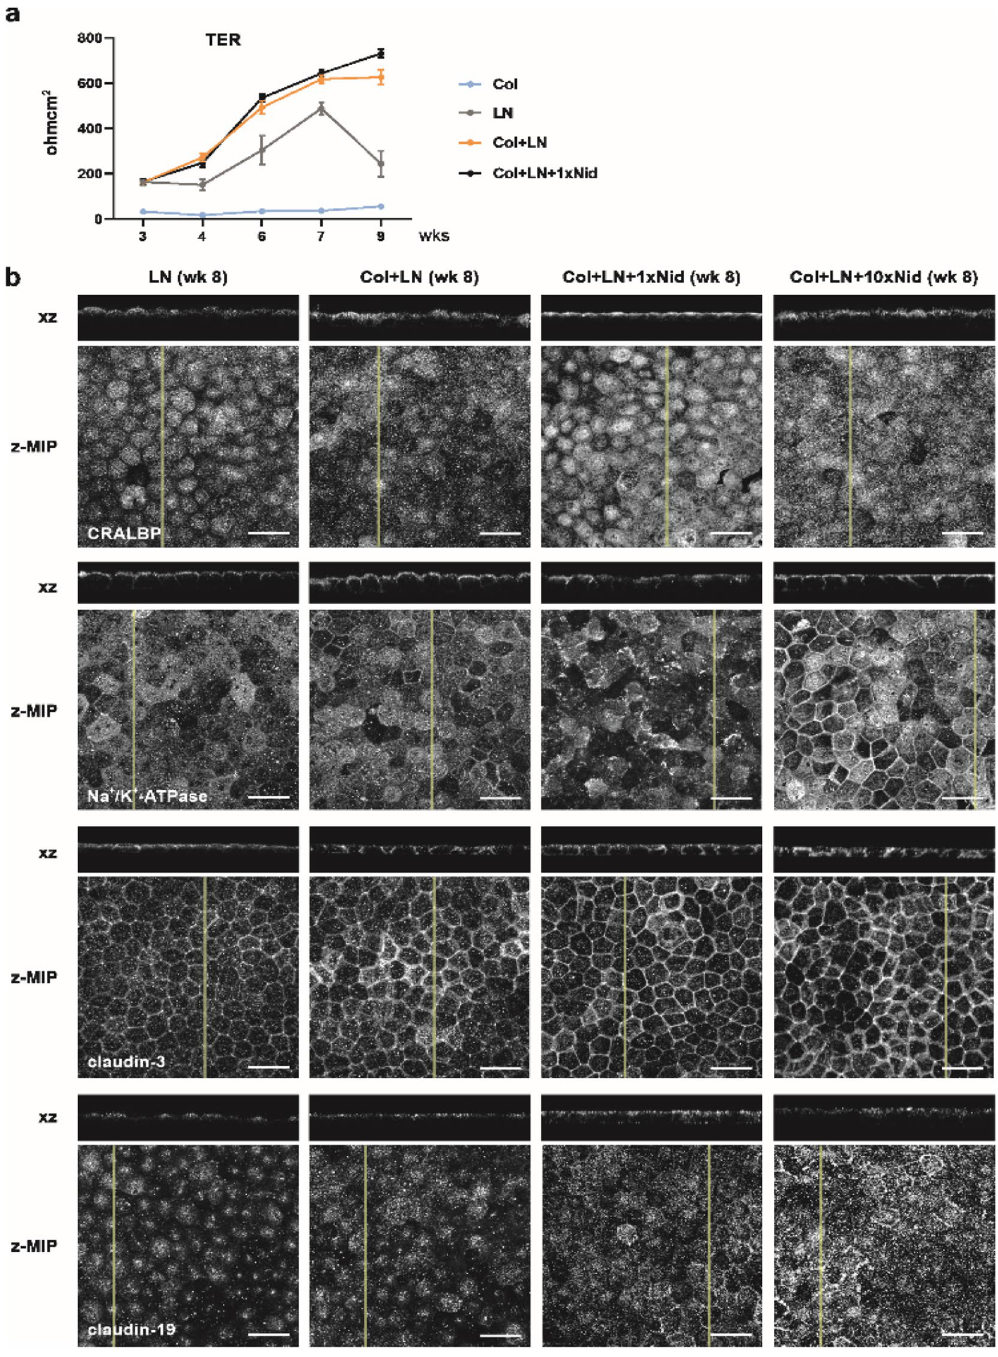
Figure 2. Barrier properties of hESC-RPE on different coatings. ( a ) TER of hESC-RPE on different coatings was measured over time. Data represents means ± SEM at 5 time points of 3 hESC-RPE lines from 3–6 biological and 6–28 technical replicates (Table 1). The differences in TER on LN compared to Col + LN are statistically significant at all time points (4 weeks p = 0.001, 6 weeks p = 0.035, 7 weeks p = 0.001, 9 weeks p < 0.0001). At 9-week time point the difference in TER between hESC-RPE on Col + LN + Nid and on Col + LN was statistically significant (p = 0.014). Statistical analysis was performed with Mann–Whitney U. ( b ) Representative (shown for hESC-08/017, Table 1) laser scanning confocal microscopy z-maximum intensity projections (z-MIP) and yz cross-sections (MIP from 10 sections) showing expression and subcellular localisation of functionally relevant proteins in hESC-RPE on different coatings after 8 weeks of culture. Scale bar 20 μm. Col—collagen IV, LN— laminin,